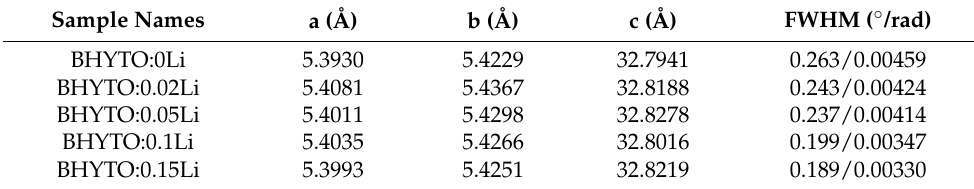
Table 2. The crystal parameters and FWHM for the BHYTO: x Li phosphors. Sample Scheme